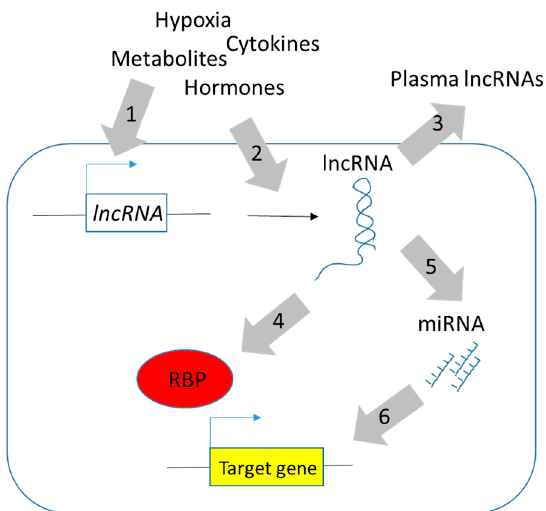
Figure 2. Proposed roles of long non-coding RNAs (lncRNAs) in obese-induced cancers. Many obese- related physiological changes such as nutrient availability, oxygen level, inflammatory cytokines, and metabolic hormones may affect the expression level (1) and post-transcriptional processing (2) of endogenous lncRNAs. Many lncRNAs can be transported to circulation and may serve as biomarkers or molecular diagnostic applications (3). Whether or not the exogenous lncRNAs contribute to the cancer progression is just emerging. In contrast, there is plentiful evidence showing that endogenous lncRNAs can regulate gene expression by diverse mechanisms. lncRNAs may act as scaffolds or molecular decoys, which directly interact with RNA binding proteins (RBPs; red circle) such as transcription factors and chromatin-modifying complexes to regulate the expression of proto- oncogenes and/or tumor suppressor genes (4). lncRNAs may act as endogenous sponges regulating gene expression via modulating microRNAs (miRNAs) availability (5 and 6).